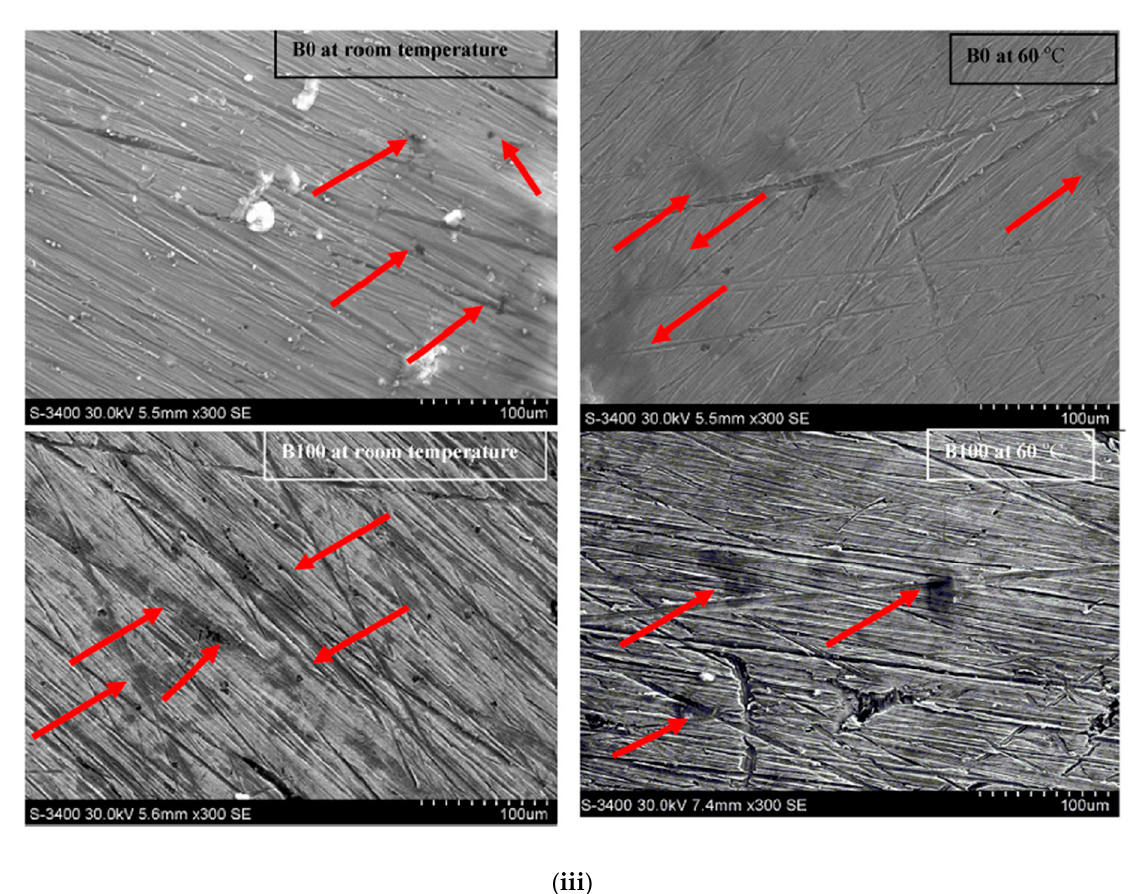
Figure 19. SEM images of Al ( i ), Cu ( ii ) and MCS ( iii ) after immersions in diesel and biodiesel for 3000 h [74].